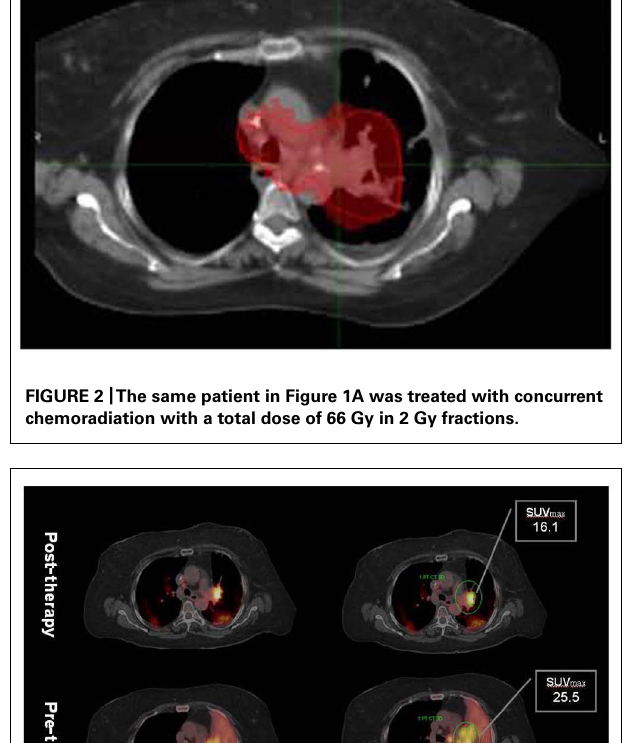
study performed preoperative F18 FDG PET/CT in 200